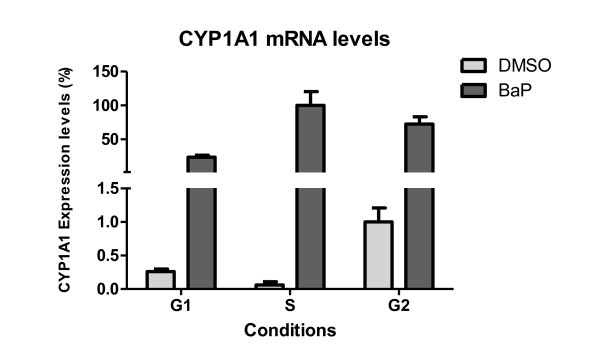
Relative CYP1A1 mRNA expression levels in synchronised MCF7 cells with and without BaP treatment. mRNA quantification was carried out by RT-PCR. The highest expressed sample in the RT-PCR was set to 100% and other samples' expressions are shown relative to that. Values represent mean ± SD from 3 determinations.